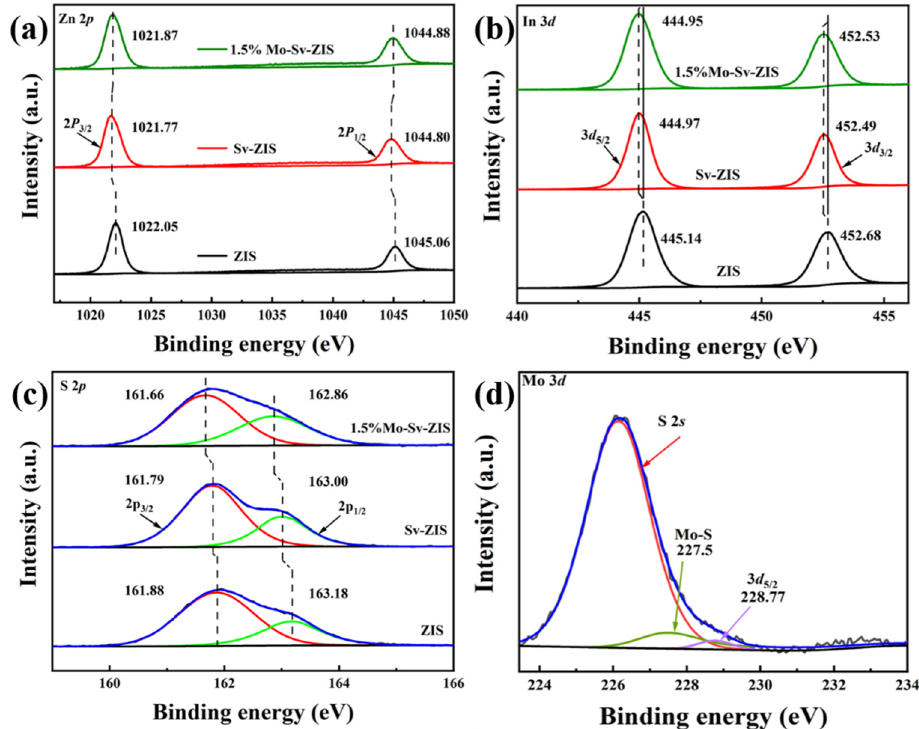
Figure 3. ( a – d ) High-resolution XPS spectra of Zn 2 p ( a ), In 3 d ( b ), S 2 p ( c ) and Mo 3 d ( d ) of ZIS, Sv-ZIS and 1.5% Mo-Sv-ZIS.